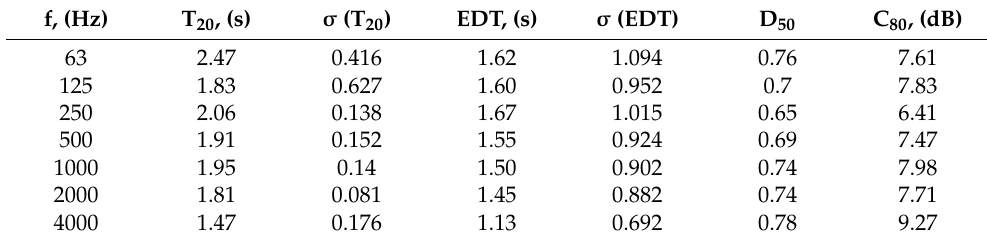
Table 6. Reverberation times and energy ratios